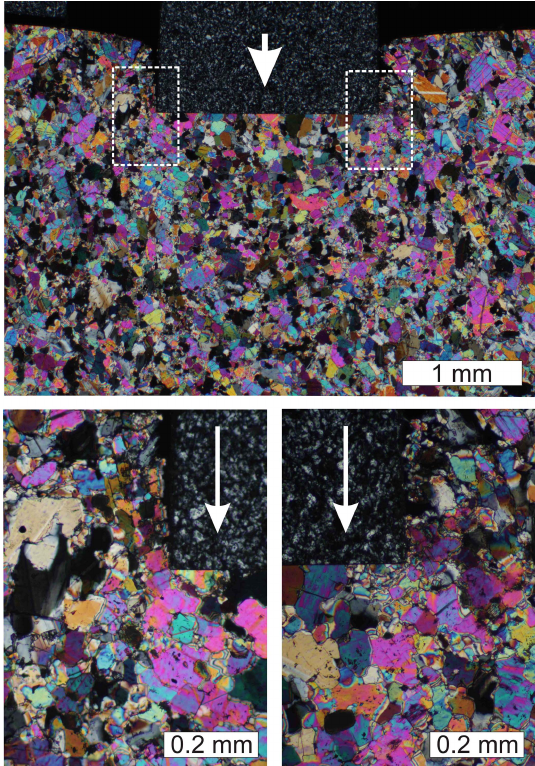
Figure 11. Close up view of anhydrite microstructure developed at the site of stress concentration along the circular edge of the indenter, and preservation within the wake flanking the crevasse (cf. Fig. 9c). Experiment AF 3: 891 ◦ C, 15MPa reference